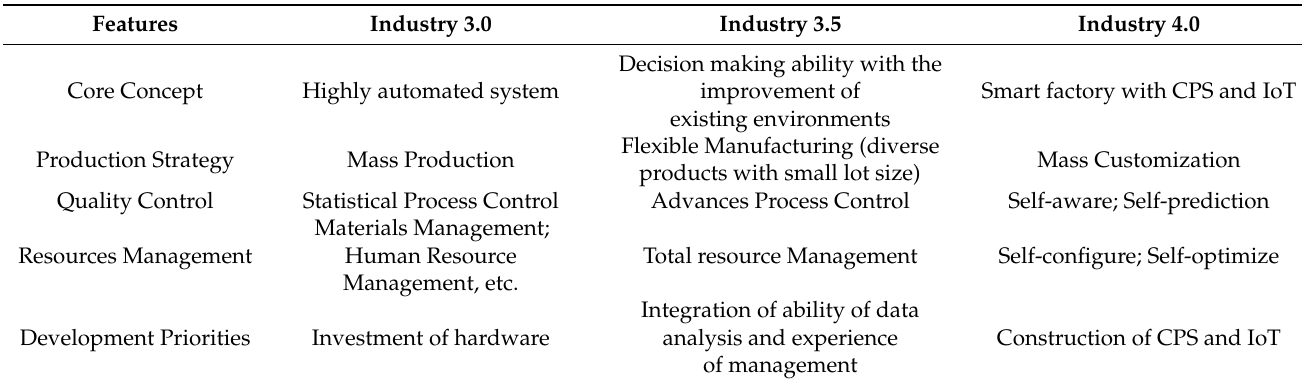
Table 1. Comparison between I3.0, I3.5 and I4.0